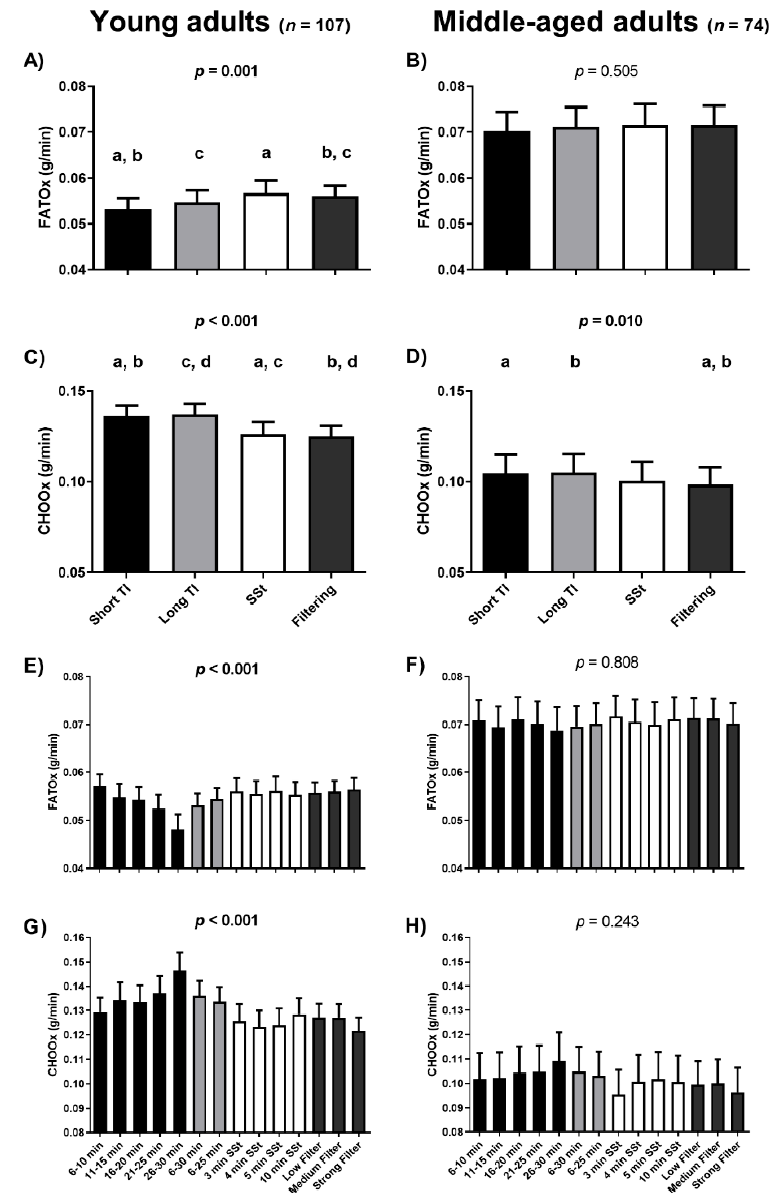
Figure 2. Di ff erences among gas exchange data selection methods with respect to fat oxidation (FATOx) and carbohydrate oxidation (CHOOx) rates. Black columns represent short time interval (TI) periods (i.e., the means of the per minute ventilation data [ p MVD] values for all variables available for these time periods, panels A – D ; the p MVD values for each short TI period, panels E , F ). Light grey columns represent long TI periods (i.e., the means of the p MVD values for all variables available for these time periods, panels A – D ; the means of the p MVD values for each long TI period, panels E , F ). White columns represent steady state (SSt) periods (i.e., the means of the p MVD values for all variables available for these SSt periods, panels A – D ; the means of the p MVD values for each SSt period, panels E , F ). Dark grey columns represent filtering methods (i.e., the means of the p MVD values for all variables available for these filtering periods, panels A – D ; the means of the p MVD values for each filtering period, panels E , F ). p -values come from repeated-measures analysis of variance (ANOVA). Identical indicatory letters highlight di ff erences as determined by post-hoc Bonferroni analysis. Data are presented as mean and standard error of the mean (SEM). Min: